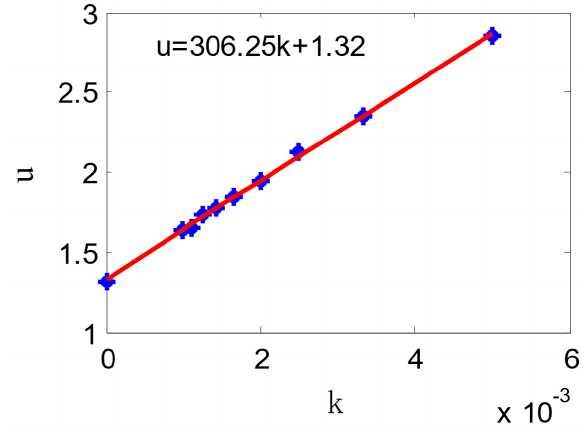
Figure 13. Voltage-curvature relation curve.